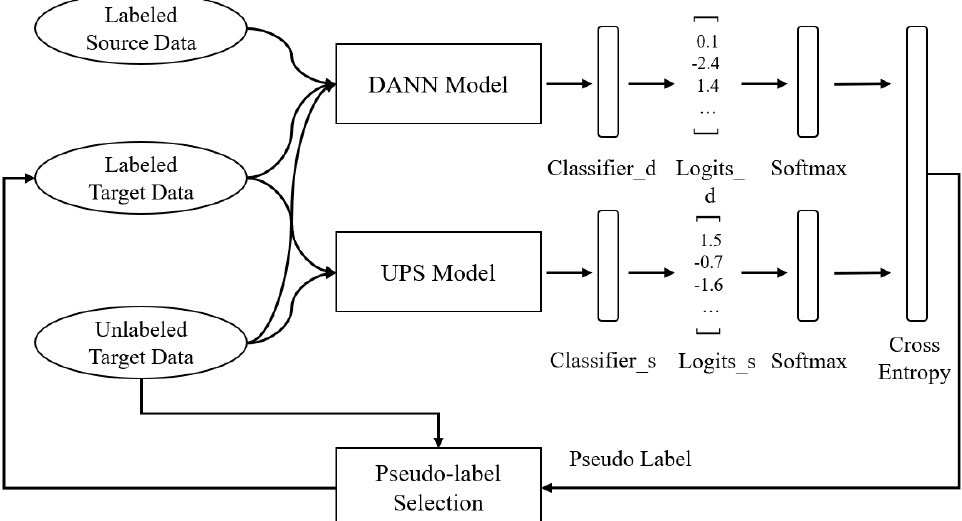
Figure 6. Model structure of proposed network based on DANN and